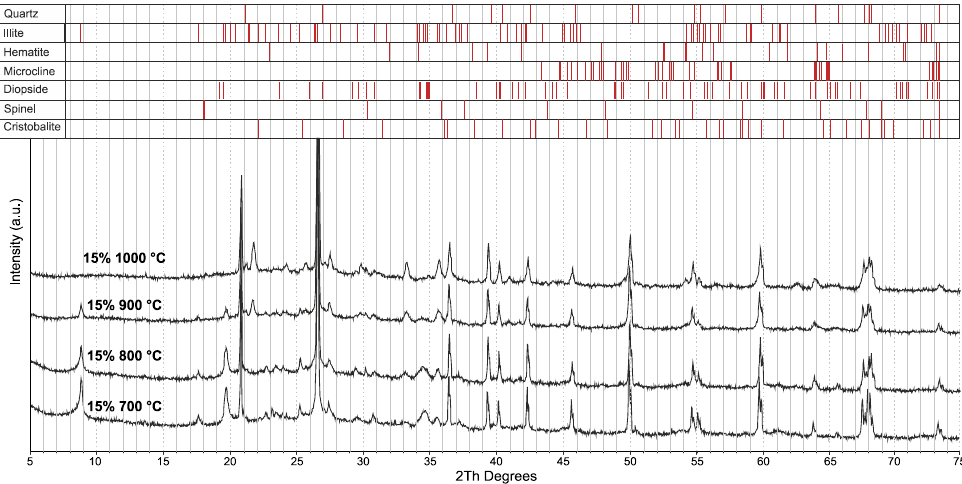
Figure 7. XRD patterns of Liepa clay with 15% of GC fired at 700, 800, 900, and 1000 °C (from bottom to top).